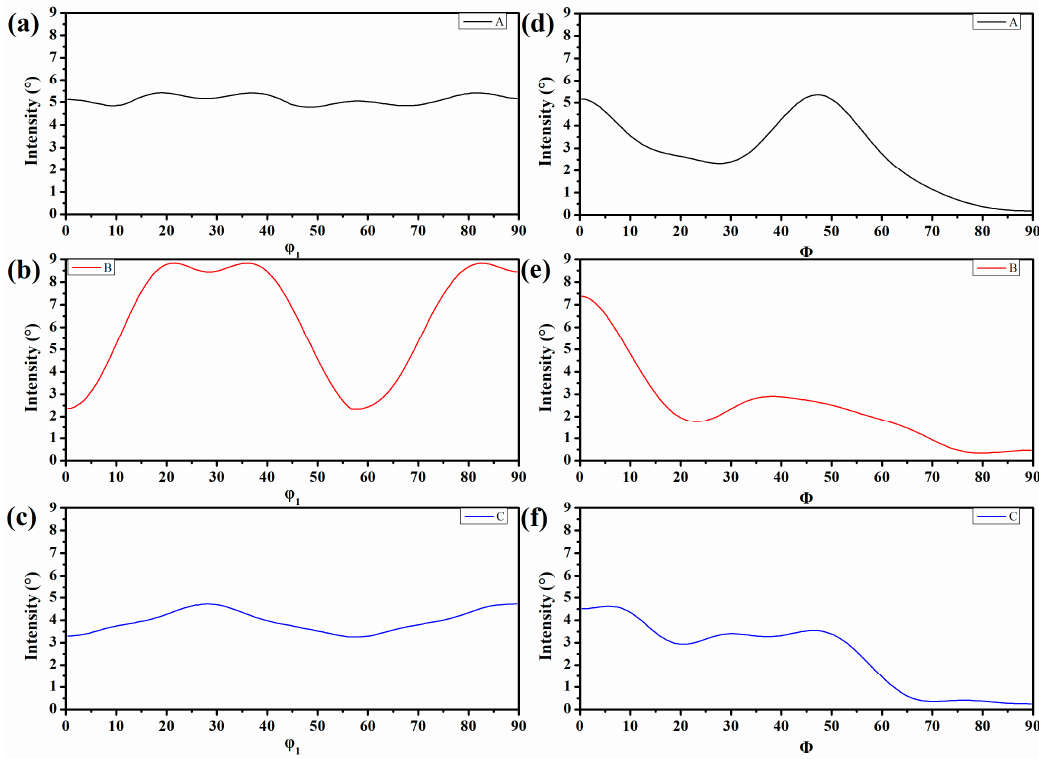
Figure 7. The exact intensity of the γ texture in specimen A ( a ), specimen B ( b ), specimen C ( c ), and the α texture ( d – f ) corresponding to ( a – c ), respectively.